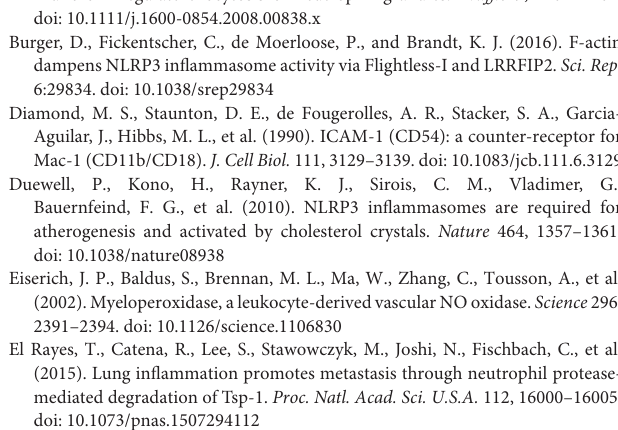
Supplementary Figure S1 | Flow cytometry analysis of Ly6G + /CD11b + double-positive neutrophils after isolation. Bone marrow-derived neutrophils were